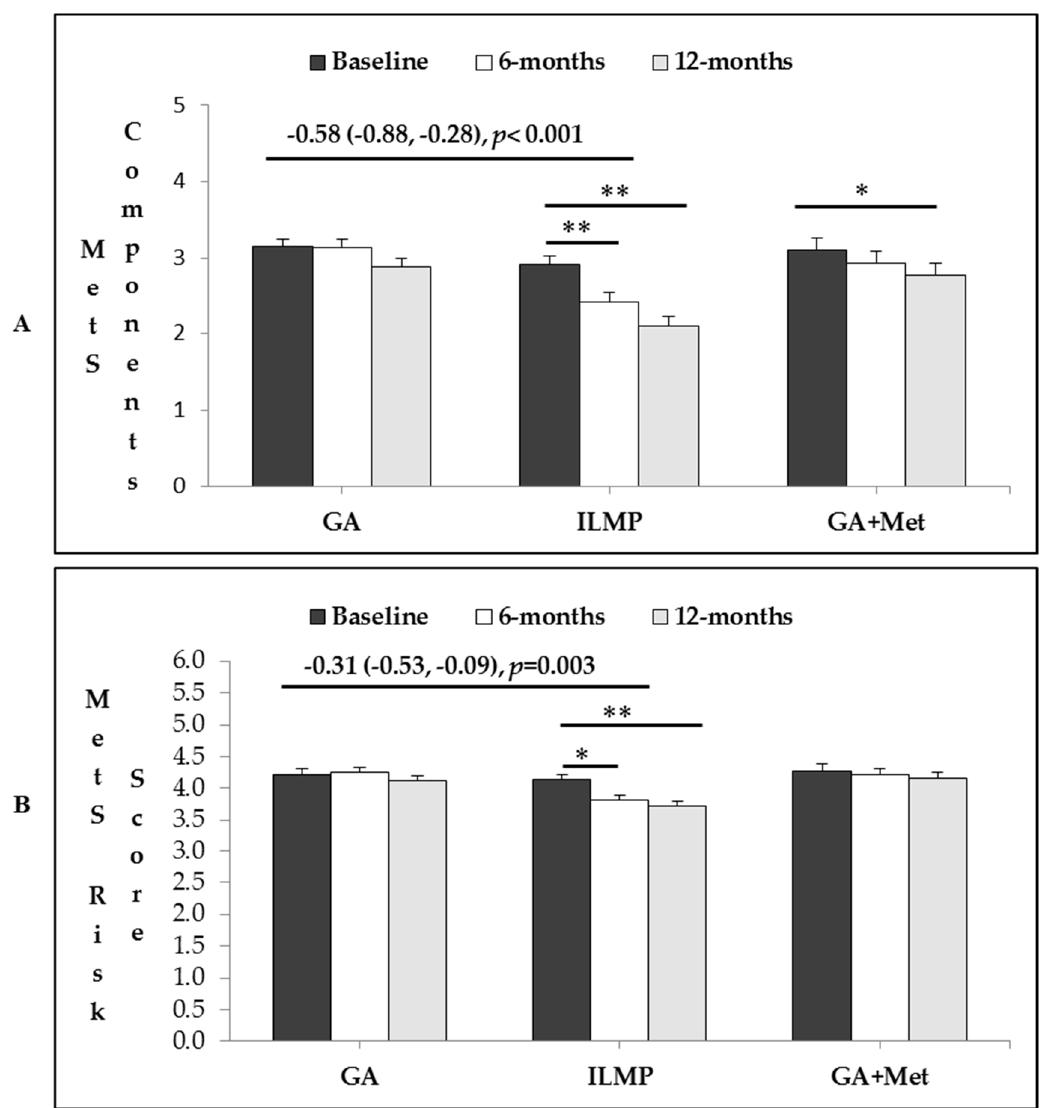
Figure 3. Intervention effects in total number of MetS components ( A ) and MetS risk-score ( B ) for three treatment strategies calculated at baseline and follow-up. Data is adjusted for age, sex and BMI, systolic and diastolic BP, waist, fasting glucose, HbA1c, and vitamin D (all baseline values). The overall change in ILMP and GA + Met groups versus GA group reported as Mean Change (95% confidence interval). Within group intervention effect is shown as * for p < 0.05 or ** for p < 0.01.